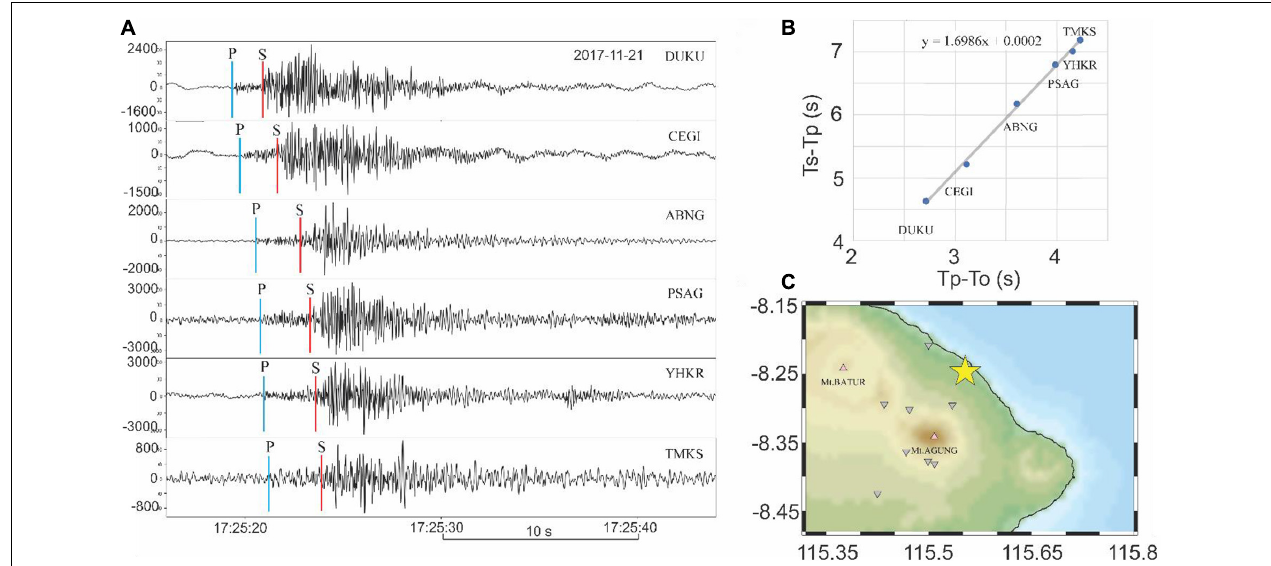
FIGURE 2 | (A) Example of picked waveforms of an event occurring on November 21, 2017 17:25:16 UTC. The event was recorded by six stations (out of eight). Only the vertical component of each recorded seismogram is shown. The P and S wave arrival times are indicated by the blue and red vertical bars, respectively. The names of the stations are written at the end of each waveform. (B) The Wadati diagram; i.e., the difference between S and P wave travel times vs. P wave travel times of the picked event. (C) Plotting of event location (indicated as yellow star) and station network (inverted